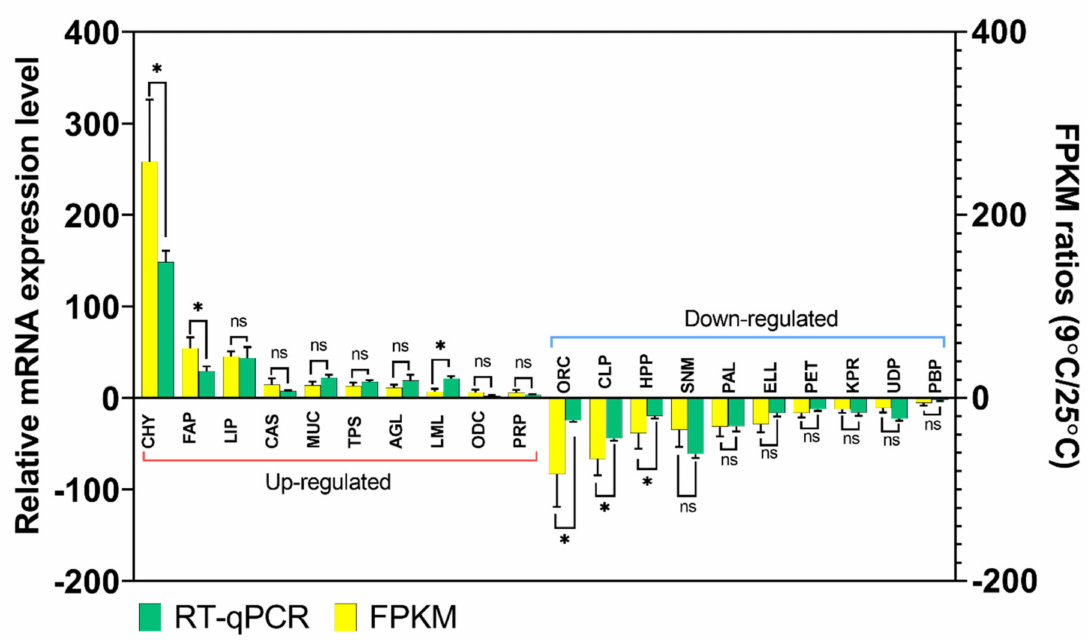
Figure 6. Differentially Expressed Genes (DEGs) validation by RT-qPCR in comparison to corresponding folding change (FC) data detected in RNA-Seq. Relative genes expression (T9/T25) is shown as the ratio of them per rpl32. Each treatment includes three technical replicates. Asterisks above standard deviation bars indicate significant difference between groups at Type I error = 0.05 (LSD test). The letter ‘ns’ stands for a non-significant difference between